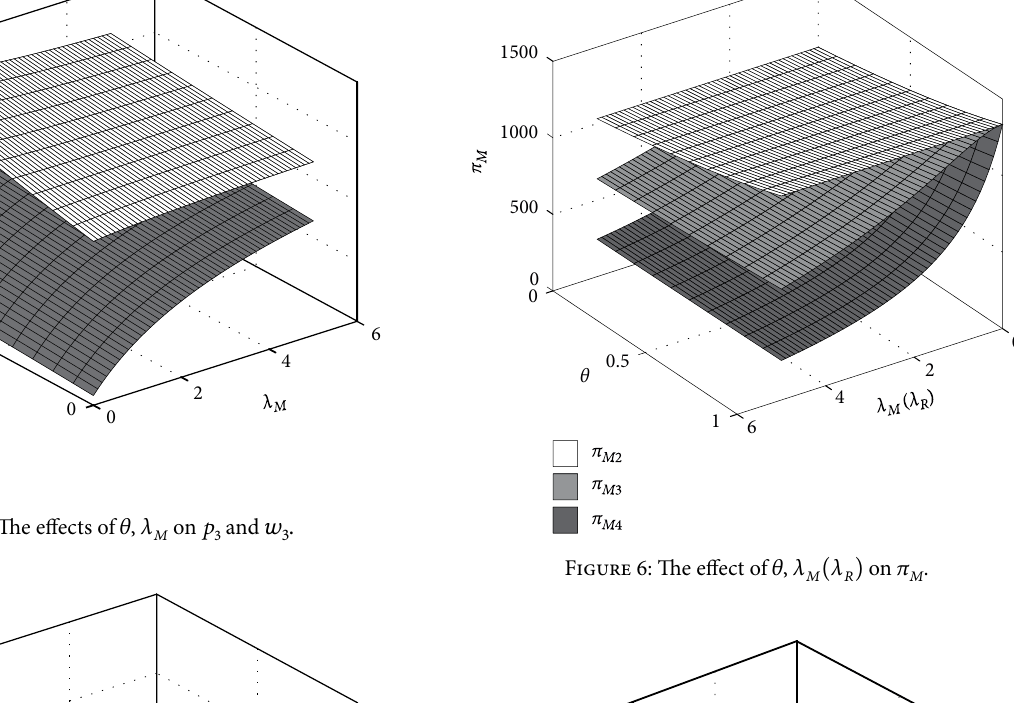
Figure 6: The effect of 𝜃 , 𝜆